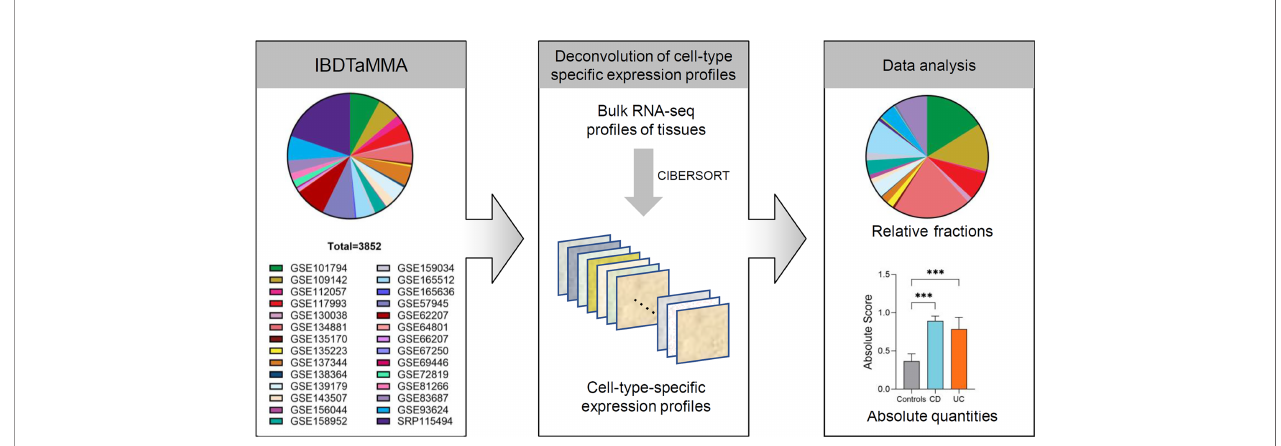
FIGURE 1 | The analytic framework of immune cells pro fi ling in patients with IBD and healthy individuals. Schematic depicting shows that CIBERSORT is applied to a multiple-cohort (n=28) gene expression pro fi les from bulk tissue transcriptomic data (a total of 3,852 subjects), comprising both patients with IBD and healthy individuals. Once immune cell fractions are determined, comparisons among different disease subtypes (CD and UC versus healthy individuals) across intestinal locations (ileum, colon, and rectum) are calculated with statistics. *** p <